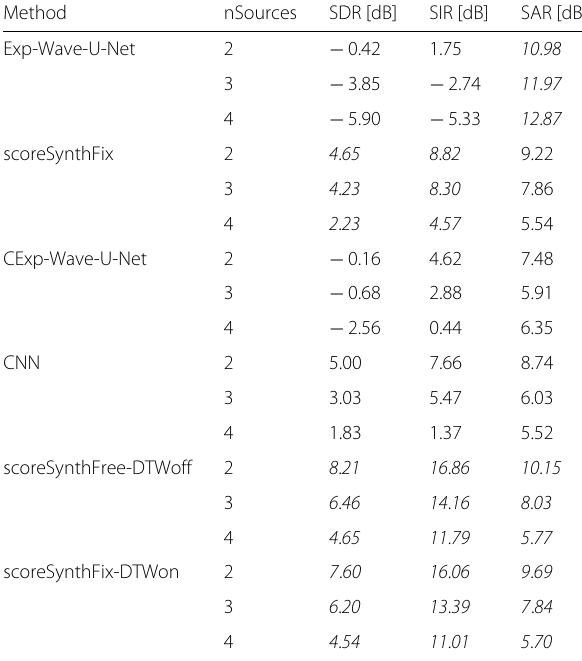
scoreSynthFix-DTWon